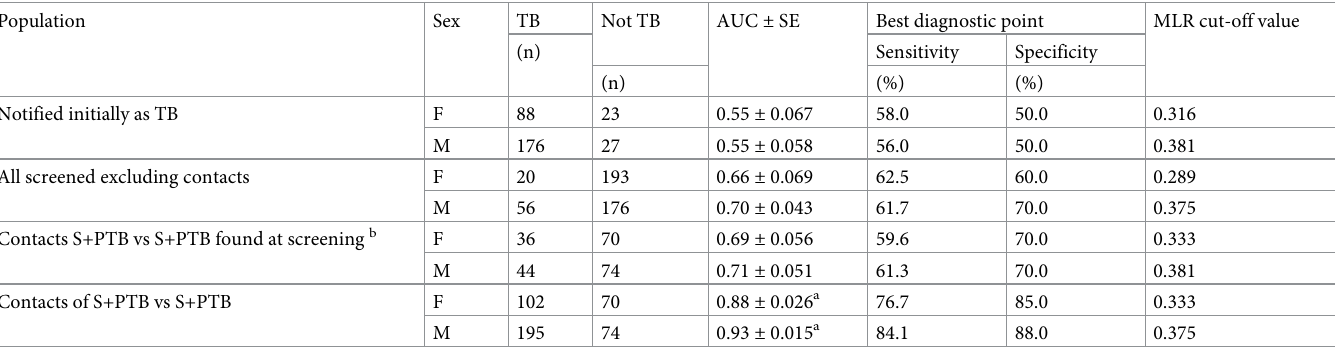
MLR limit was 0.474 (95%CI 0.469 to 0.482) and for males was 0.505 (95% CI 0.497 to 0.515). The sensitivities and specificities derived using these values for the different populations are given in S4 Table in S2 File, but positive likelihood ratios were all < 10. In patients with all forms of TB within the 3-year cohort, six patients had an MLR below the lower cut-off limits, two with culture-positive TB; two had diabetes, one HIV co-infection (culture-positive), one an alcohol problem, one with malnutrition (culture-positive) and one with no co-morbidities. Using the upper MLR cut-off values, the associations observed in the univariate analysis (Table 2) were confirmed. More patients with culture-positive TB from any Table 5. Definition of best diagnostic points from ROC